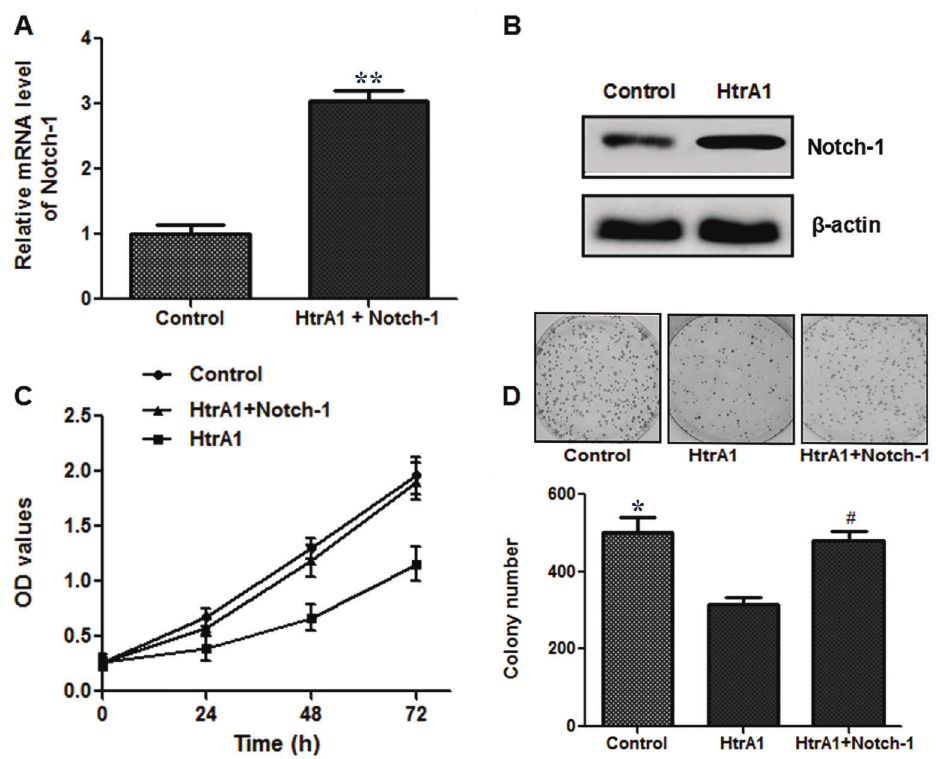
Figure 5. The pancreatic cancer PANC-1 cells over-expressing high temperature requirement factor A1 (HtrA1) were transfected with pcDNA3.1-Notch-1 plasmids. Then, real-time PCR and western blot were performed to determine the mRNA ( A ) and protein ( B ) levels of Notch-1, respectively. Cell viability and colony number were measured by CCK-8 assay ( C ) and colony formation assay ( D ). Data are reported as means ± SD. *P o 0.05; **P o 0.01 compared to control; # P o 0.05 compared to cells over-expressing